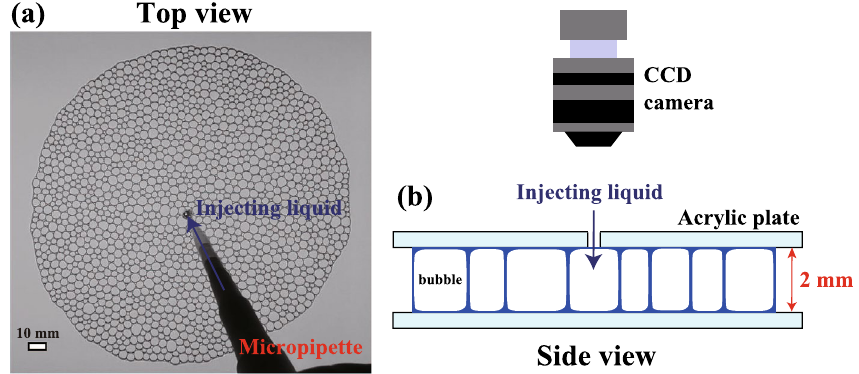
Figure 1. ( a ) and ( b ) Schematic of the experimental setup from the top and side, respectively. We slowly inject a solution (700 μl) into a foam from the small hole pierced in the center of the acrylic plate using a micropipette. rearrangement